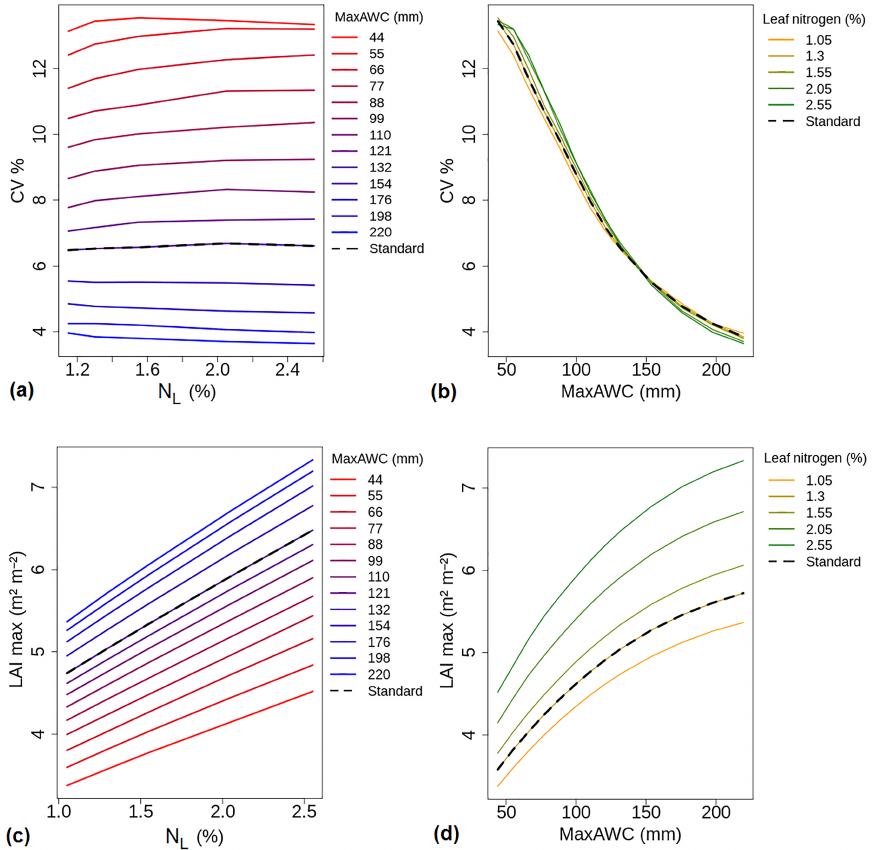
Figure 3. Impact of MaxAWC and N L parameters on the annual maximum LAI simulated by ISBA and on its interannual variability. The interannual variability is quantified using the coefficient of variation (CV, in %). Mean CV values (across all 45 départements) are plotted as a function of (a) N L and (b) MaxAWC, for various values of MaxAWC and N L , respectively. Mean LAI max values (across all 45 départements) are plotted as a function of (c) N L and (d) MaxAWC, for various values of MaxAWC and N L , respectively. The dashed lines are obtained using standard average ISBA parameter values (MaxAWC = 132mm and N L =